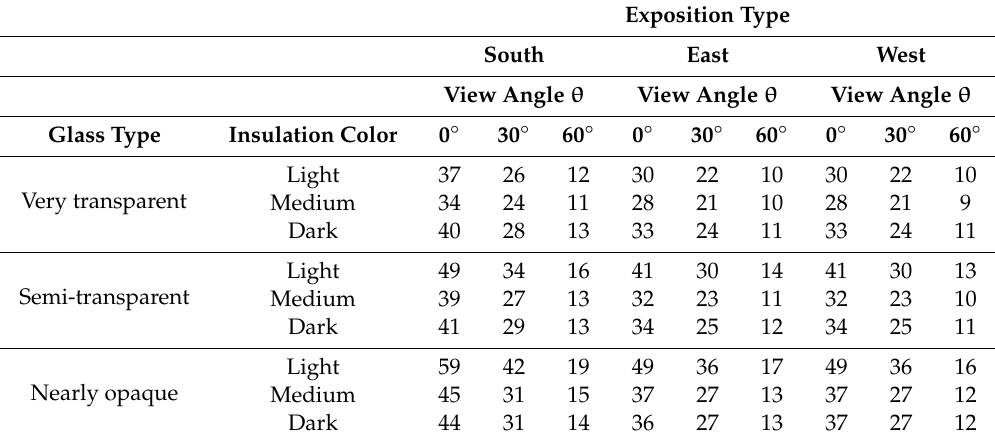
Table 5. Maximum temperature gradients (K) for New